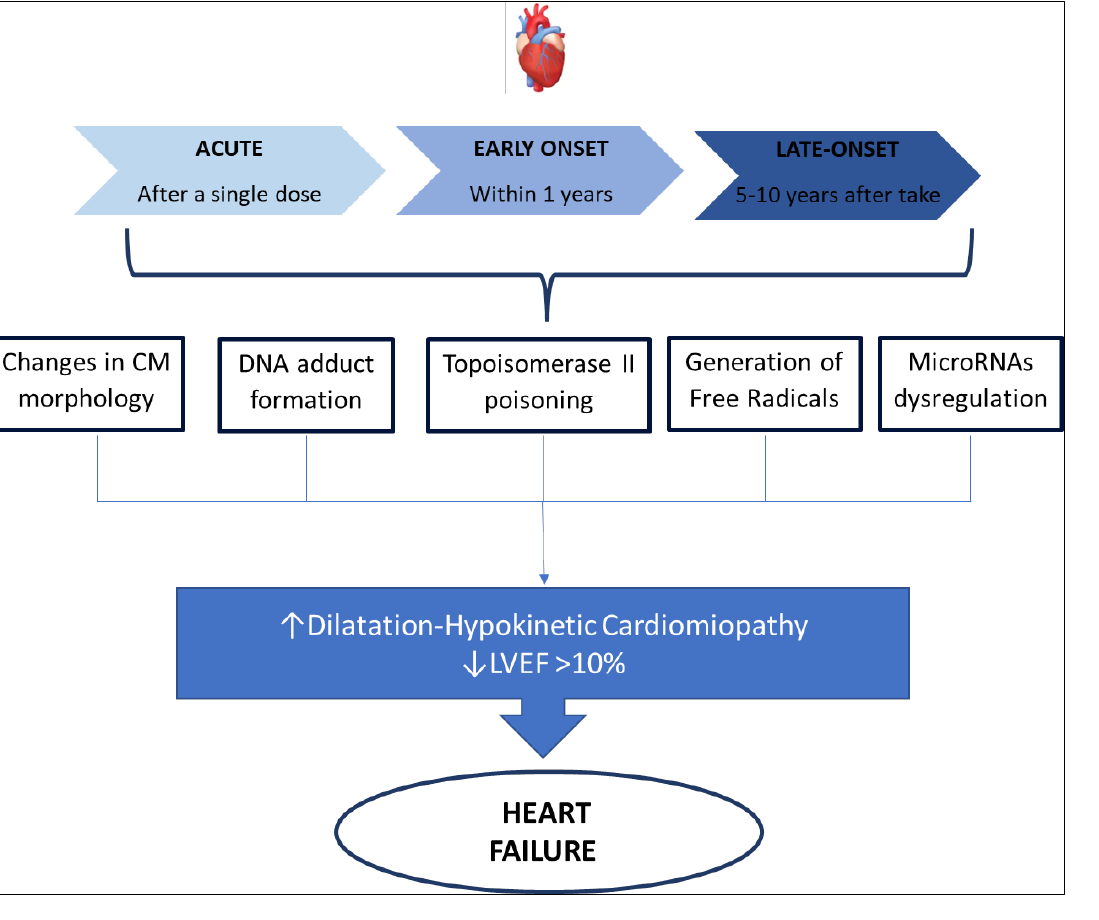
Figure 1. Anthracycline-induced cardiotoxicity mechanisms. Abbreviation: LVEF, left ventricular ejection fraction. CM, Cardiomyocytes.